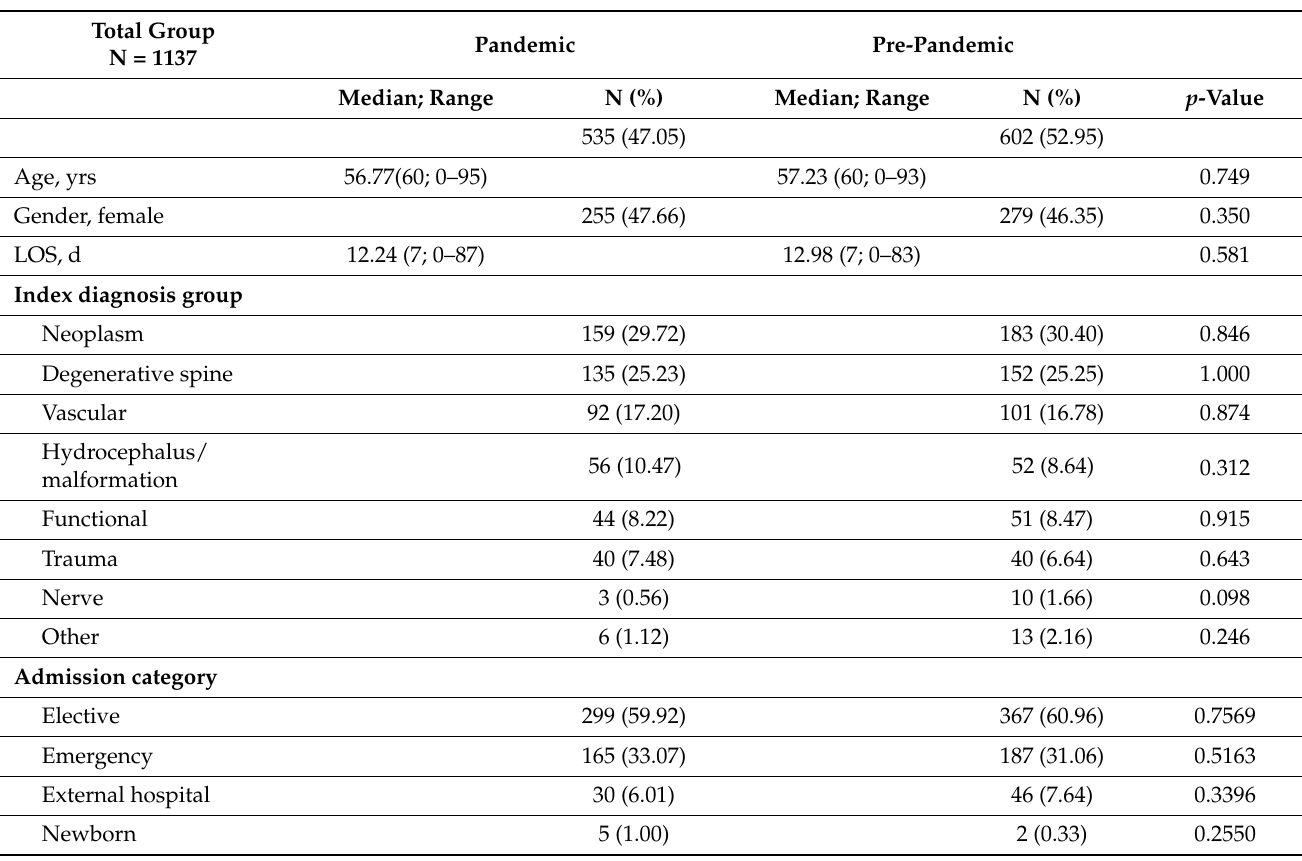
Table 1. Patient demographics and operation procedures for the pandemic and pre-pandemic patient group. Total